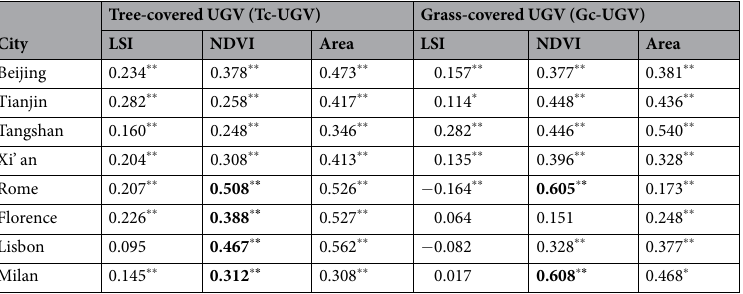
Table 1. The relationship between three indexes (LSI, NDVI, area) and the cooling intensity of UGV. * Correlation is significant at the 0.05 level (2-tailed). ** Correlation is significant at the 0.01 level (2-tailed).